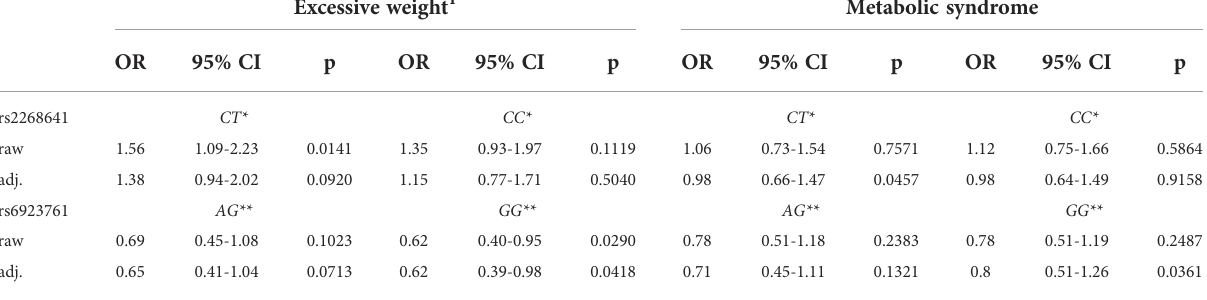
TABLE 4 Logistic regression investigating the association of rs2268641 and rs6923761 variants with excessive weight and metabolic syndrome. Excessive weight 1